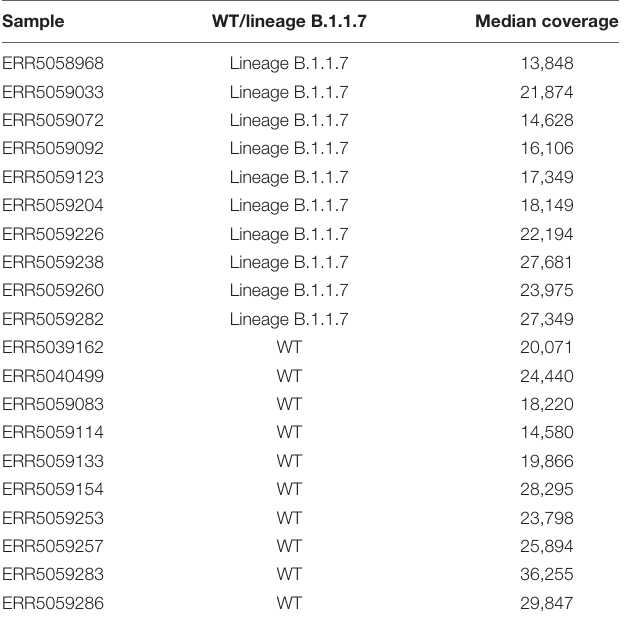
TABLE 2 | List of SRA accession numbers used for employed wild-type and lineage B.1.1.7 samples in this study.